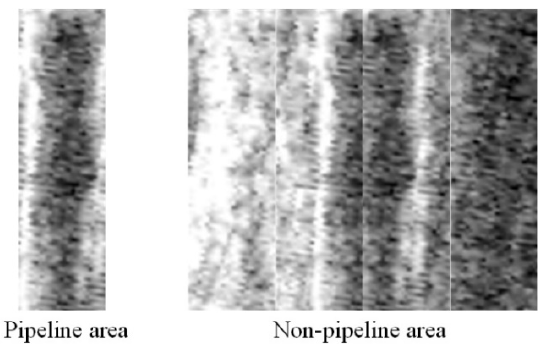
Figure 14. Divided ultrasonic image into two kind samples: pipeline area and non-pipeline area.